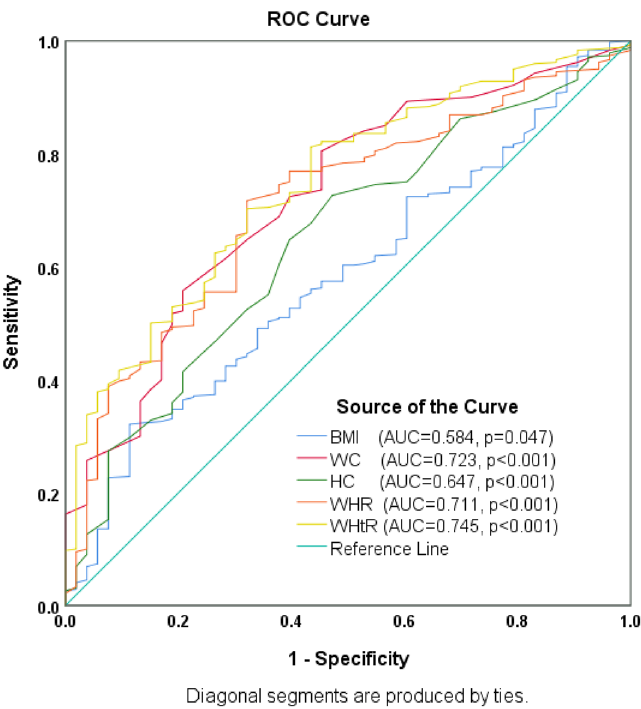
Figure 1. ROC curve analysis for comparison of BMI, WC, HC, WHR and WHtR in determining VF levels in diabetic